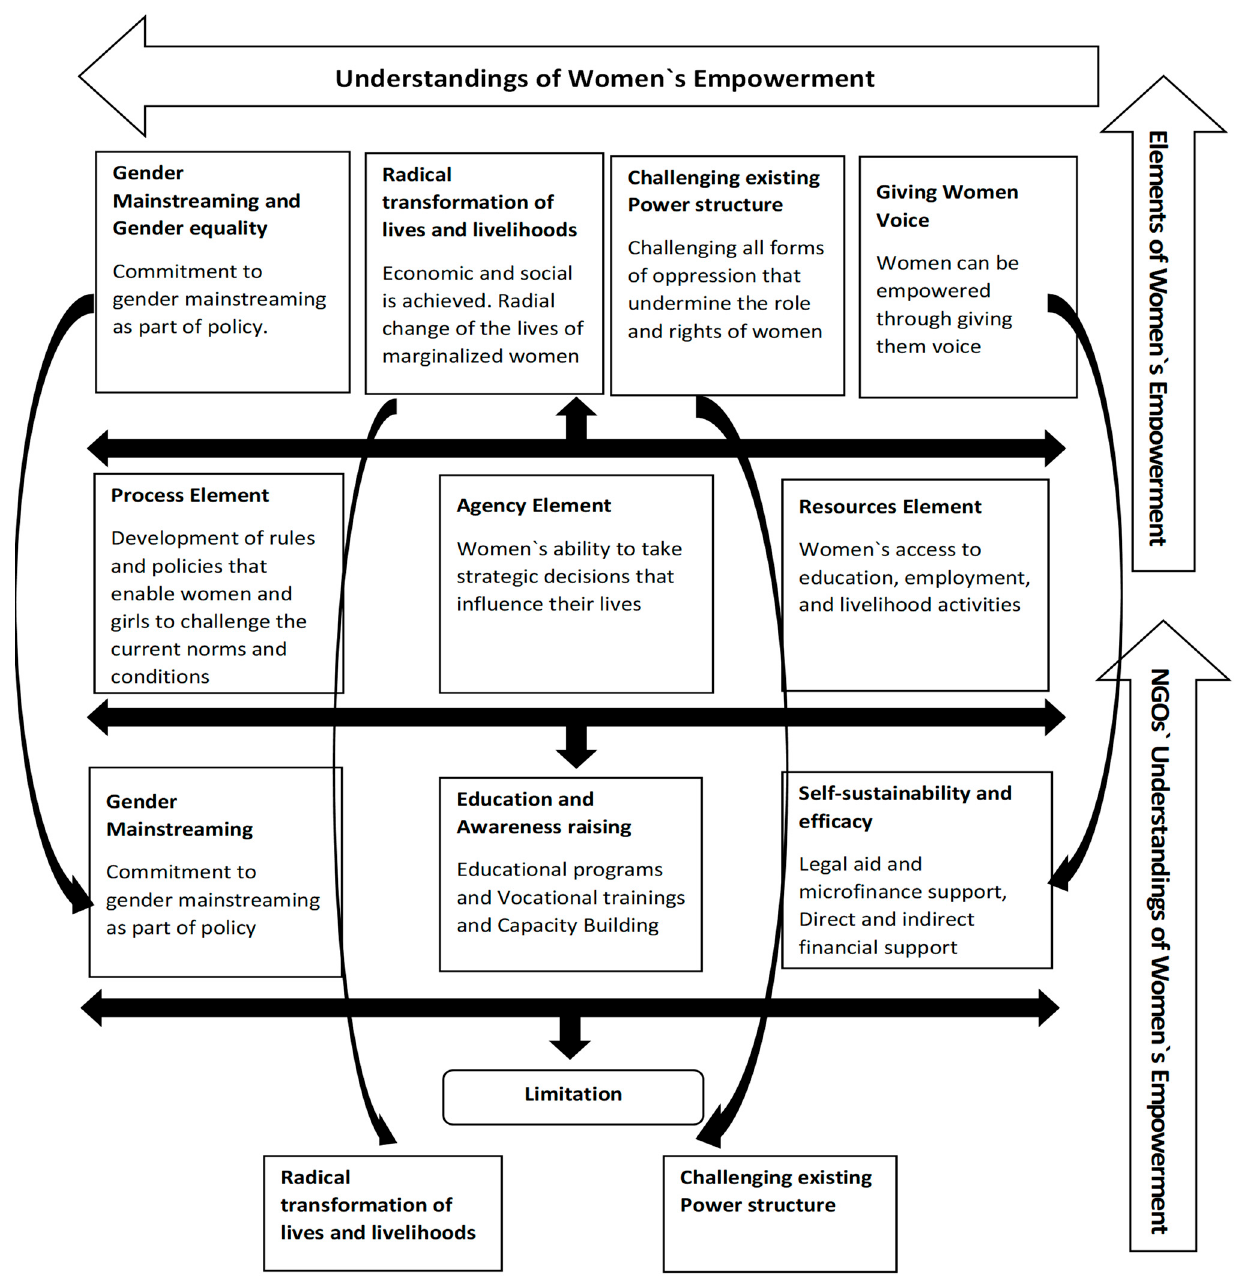
Figure 1. Conceptual framework of understandings for women’s empowerment: insights and limitations from NGOs’ work.